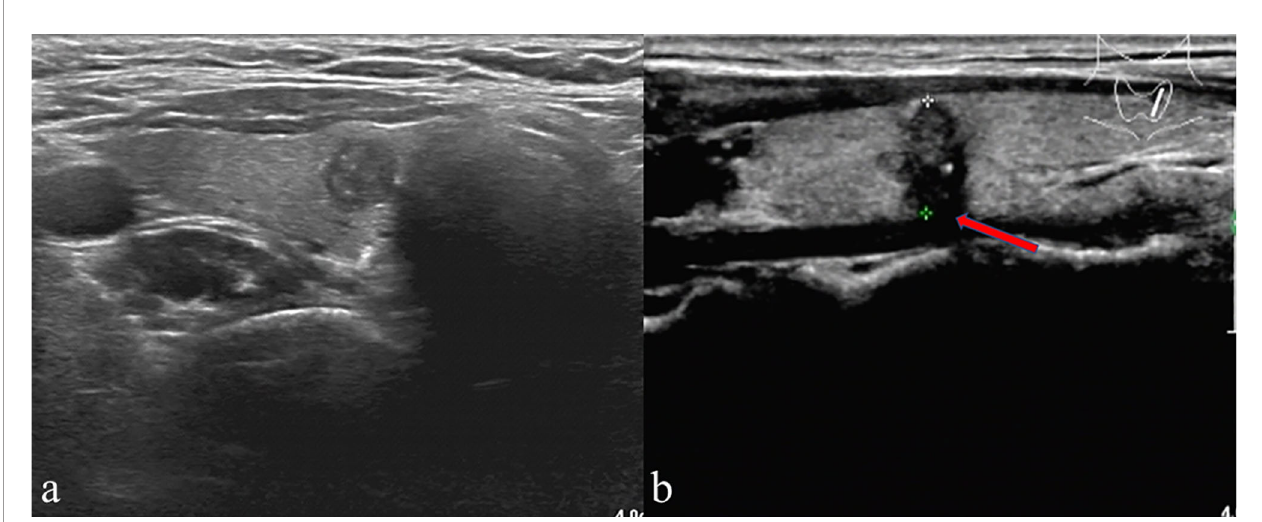
FIGURE 1 | (A) A patient ’ s thyroid ultrasound showed punctated hyperecho in the nodule, indicating the presence of microcalci fi cation. (B) A representative patient with ETE showed echogenic capsule line loss at the contact site of the lesion (red arrow) and microcalci fi cation in the